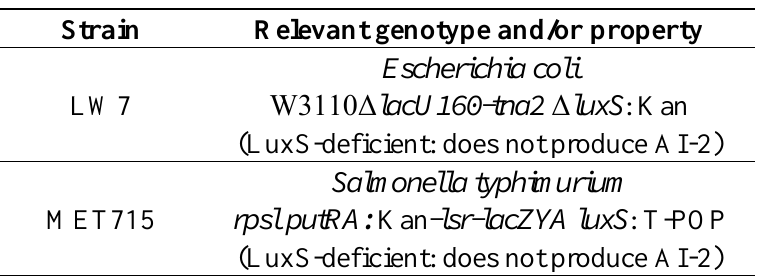
Table 1. Bacterial strains used in this